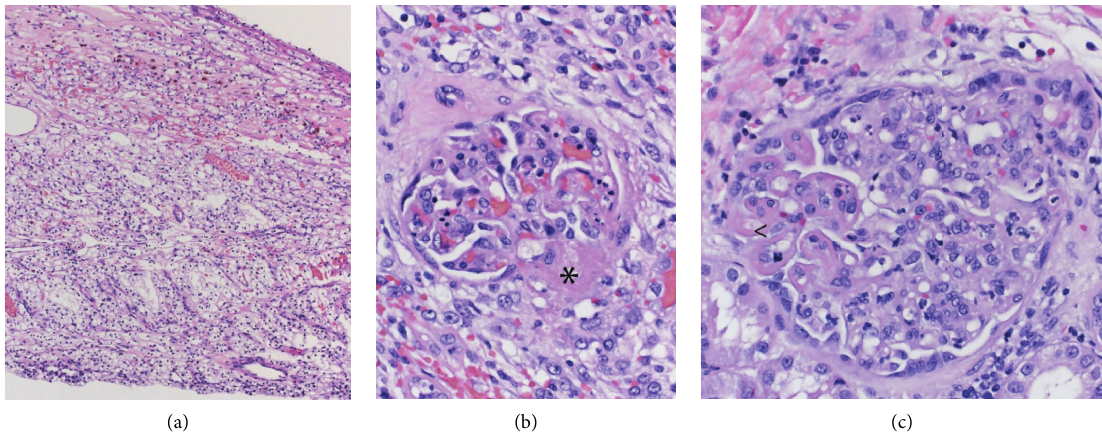
Figure 3: Clear cell renal cell carcinoma, low grade of partial nephrectomy (a). In adjacent nonneoplastic kidney, several glomeruli show segmental to global endocapillary proliferation with segmental necrotizing lesion ( ∗ ) in (b) and rare glomeruli show large glomerular deposits ( < ) in (c). Original magnification: 40X in (a) and 400X in (b) and (c).